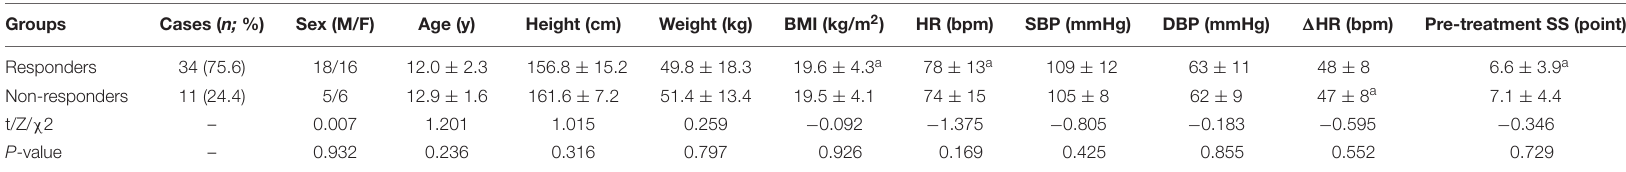
TABLE 3 | Comparison of demographic, hemodynamics parameters and pre-treatment SS (symptom scores) between POTS children with response and non-response to metoprolol.